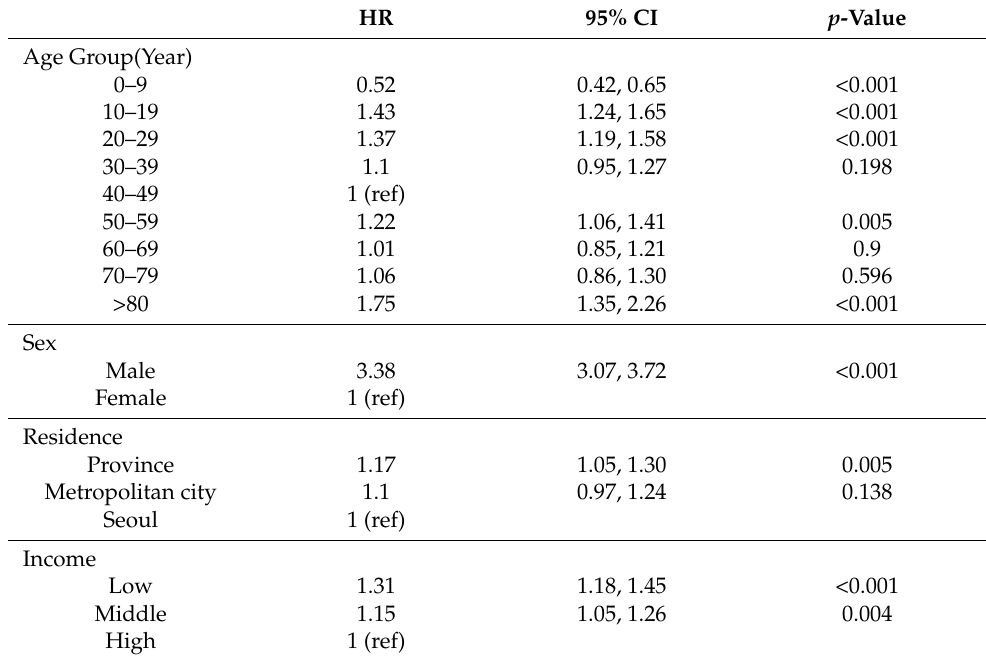
Table 4. Factors associated with orbital wall fractures based on multivariable Cox regression